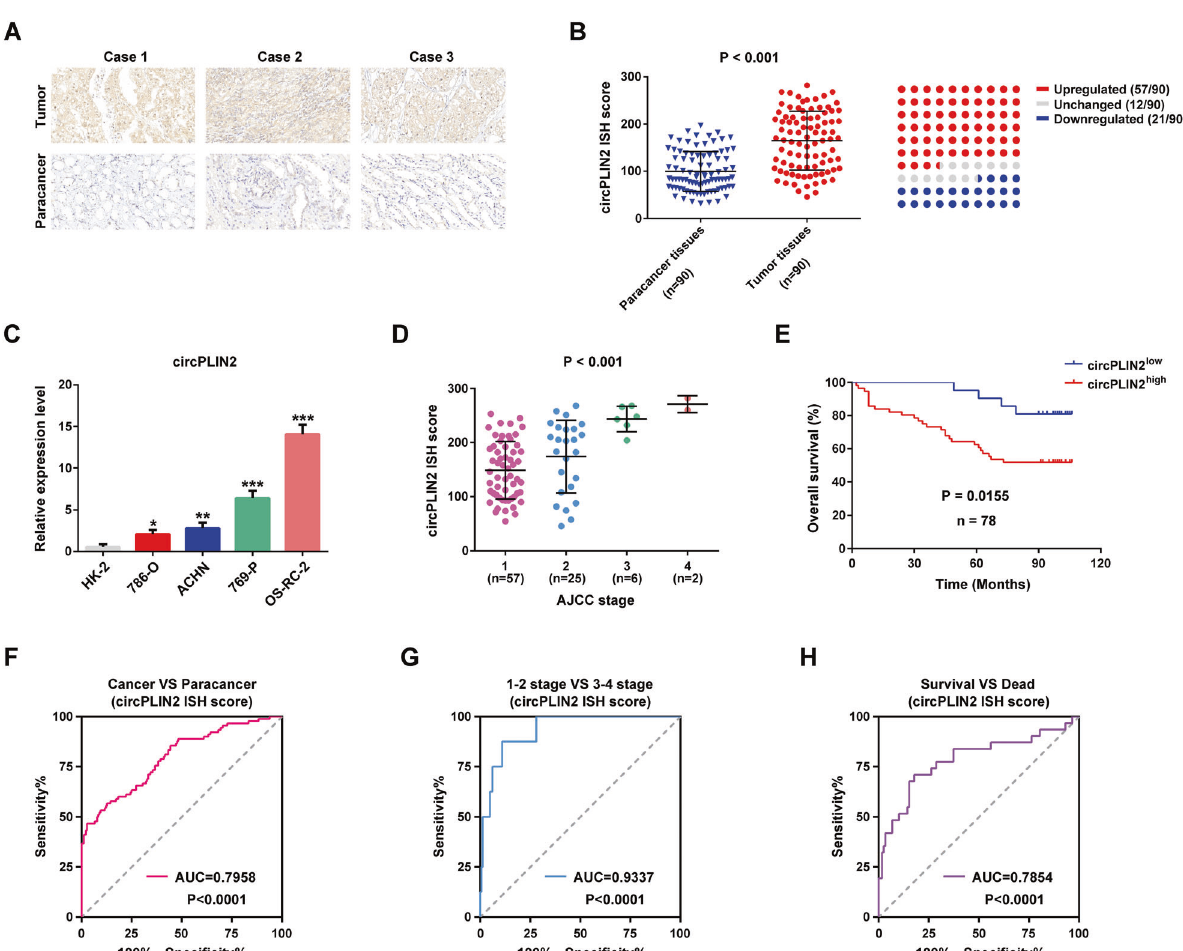
Fig. 2 circPLIN2 is signi fi cantly upregulated in ccRCC and correlated with the progression and poor prognosis of ccRCC patients. A Representative images of in situ hybridization (ISH) for circPLIN2 expression in three pairs of samples from the ccRCC tissue microarray. Scale bar, 20 μ m. B circPLIN2 ISH staining scores in 90 pairs of cancerous and paracancerous tissues are shown on the left, and the expression pro fi les of circPLIN2 in 90 patients with ccRCC are shown on the right. C RT – qPCR analysis of the relative expression levels of circPLIN2 in a panel of four human ccRCC cell lines (786-O, ACHN, 769-P, and OS-RC-2) and an immortalized proximal tubule epithelial cell line (HK-2). The relative circPLIN2 expression level was normalized to GAPDH. D circPLIN2 ISH staining scores in ccRCC tissues ( n = 90) in different AJCC stages. E Overall survival curve of ccRCC patients with high ( n = 57) or low ( n = 21) circPLIN2 expression. Statistical signi fi cance was determined using the Kaplan – Meier test. F – H The receiver operating characteristic curve (ROC) analysis for cancer and paracancer ( F ), AJCC stage 1 – 2 and 3 – 4 ( G ), survival and death ( H ) in 90 ccRCC patients based on the circPLIN2 ISH staining scores. Two-tailed Student ’ s t test. The error bars represent S.D. * p < 0.05, ** p < 0.01, and *** p < 0.001. distributed in the cytoplasm, RNA pull-down assays (tagged RNA circPLIN2 regulates the stability of the c-Myc and MARCKSL1 af fi nity puri fi cation assays) were performed to identify the mRNAs by binding to the KH domains of IGF2BP proteins proteins that bound to circPLIN2 in the cytoplasm, and then CircRNAs have been shown to interact with RNA-binding proteins puri fi ed proteins were subjected to liquid chromatography – mass to regulate protein functions [15 – 20]. As circPLIN2 was mainly Cell Death and Disease (2022)